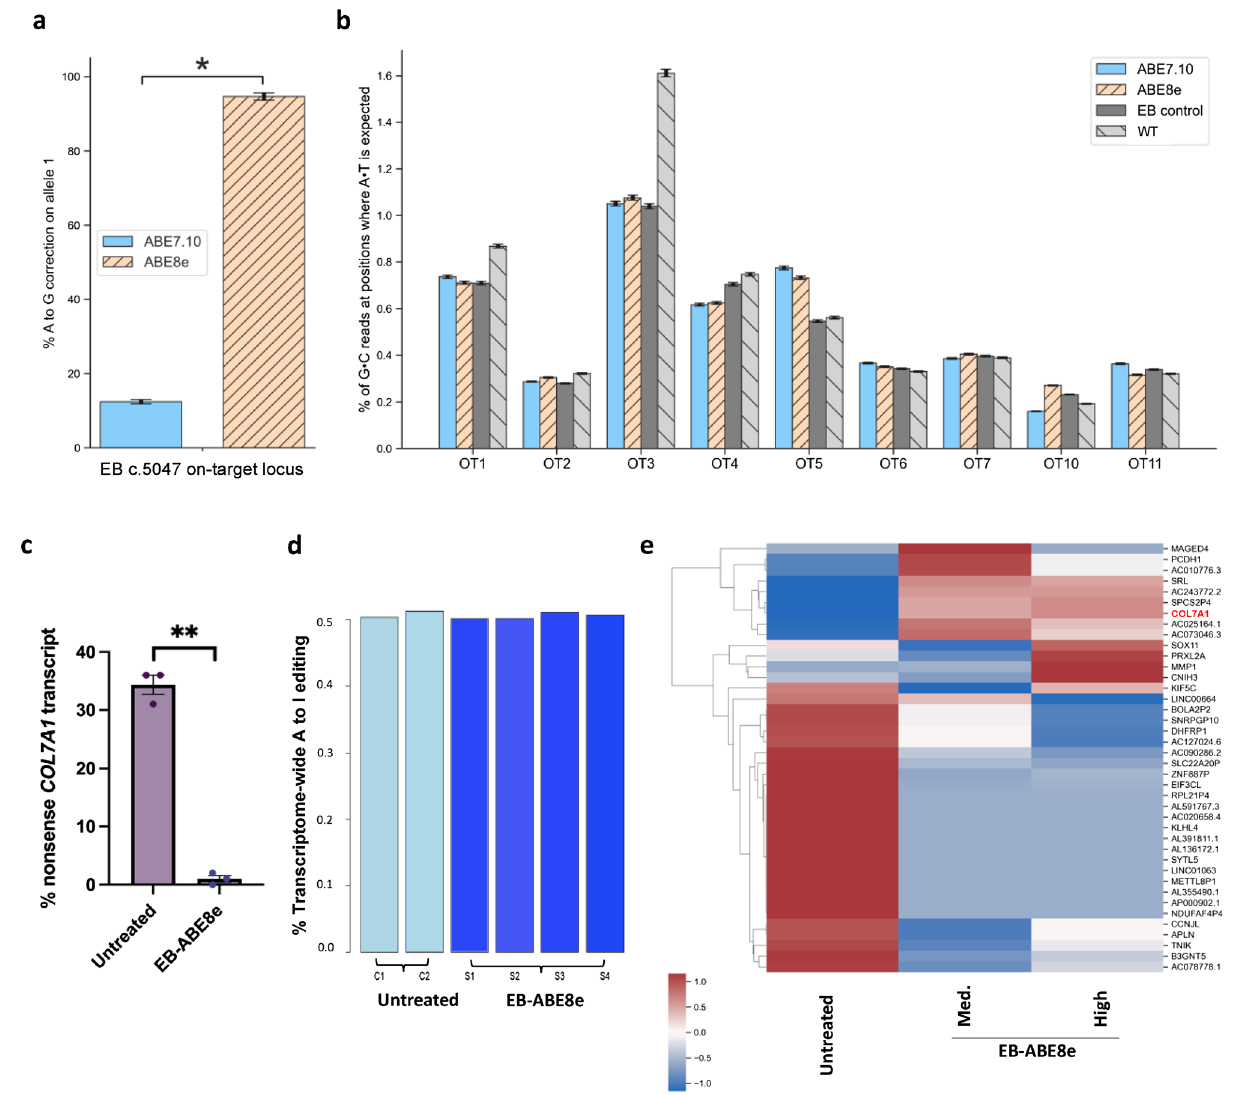
Figure 3. Assessment of effects of mutation correction on the transcriptome and genomic landscape. ( a ) NGS analysis of the on-target site found ABE7.10 corrected 12.4% of mutated alleles whereas ABE8e treatment led to 94.6% correction. Statistical difference and error bars were calculated using the Wald method. ( b ) 9 of the 10 predicted most likely sites for off-target editing across the genome were interrogated using NGS, illustrating negligible off-target editing activity following ABE7.10 and ABE8e treatment at all 9 sites. Error bars were calculated using the Wald method. ( c ) 0.5% of EB COL7A1 RNA transcripts contained the nonsense mutation at c.5047 after treatment with ABE8e, compared to 36% without treatment. 3 technical replicates performed. Significance calculated using paired t -test ( p = 0.0013) ( d ) ABE8e treatment led to no increase in A-to-I changes across the transcriptome ( e ) A heatmap generated from the log2 FPKM of the top 40 differentially expressed genes using the clustermap function of Python’s seaborn library, (version 0.11 https:// seabo rn. pydata. org/ gener ated/ seabo rn. clust ermap. html) is shown. Untreated EB fibroblasts were compared with fibroblasts treated with 5 µg sgRNA + 2 µg ABE8e (EB-ABE8e), as before, and to fibroblasts treated with 1 µg sgRNA + 2 µg ABE8e. The condition with 1 µg sgRNA + 2 µg ABE8e was termed EB-ABE8e Medium dose and the condition with 5 µg sgRNA + 2 µg ABE8e was termed EB-ABE8e High dose. COL7A1 expression , highlighted in red, was increased after both treatments, with a greater increase following administration of EB-ABE8e High